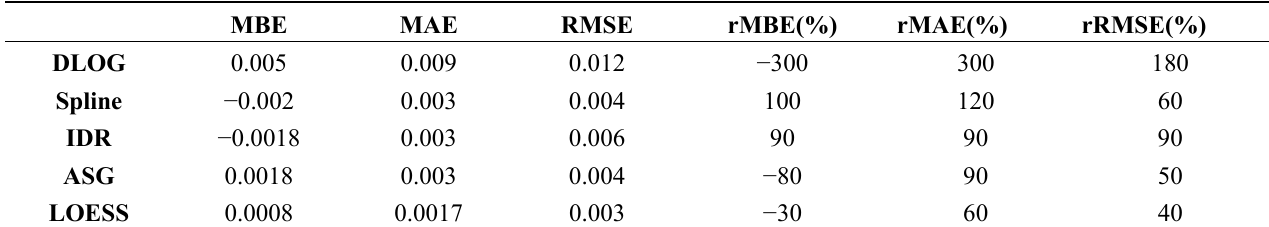
Table 2. Performance measures averaged over the nine sites, for simulations with μ = − 0.01, σ = 0.01. MBE MAE RMSE rMBE(%) rMAE(%) rRMSE(%) DLOG 0.005 0.009